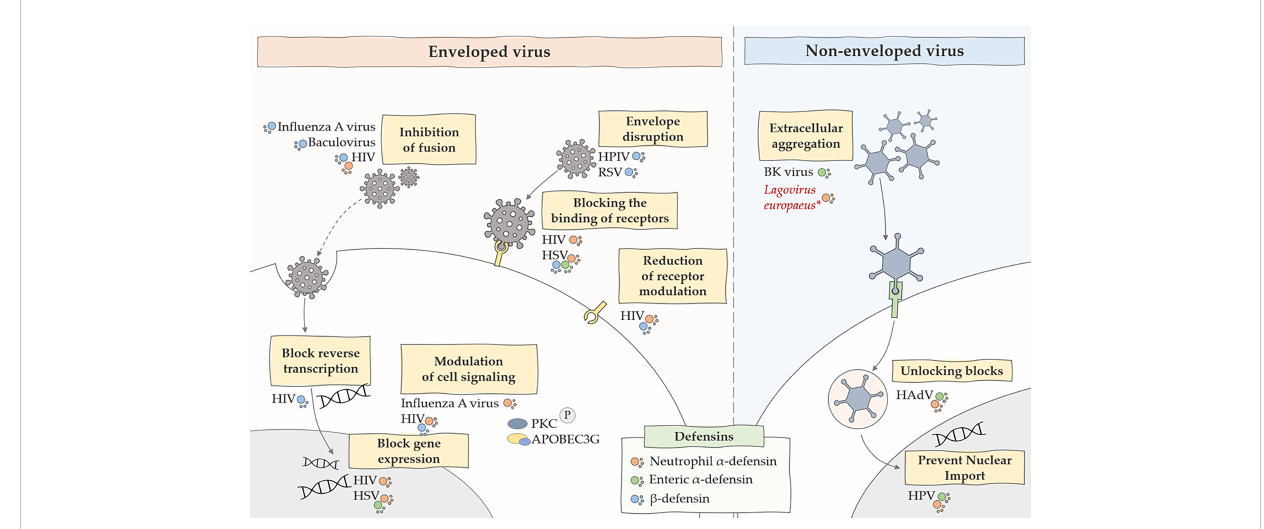
FIGURE 1 Summary of the main antiviral mechanisms of defensins. The fi gure shows the inhibitory effect of defensins on many stages of viral infections caused by enveloped and non-enveloped viruses. HIV, human immunode fi ciency virus; HSV, herpes simplex virus; HPV, human papillomavirus, HPIV, human parain fl uenza viruses, RSV, respiratory syncytial virus; *, predicted effect of rabbit a -defensin on inhibition of Lagovirus europaeus